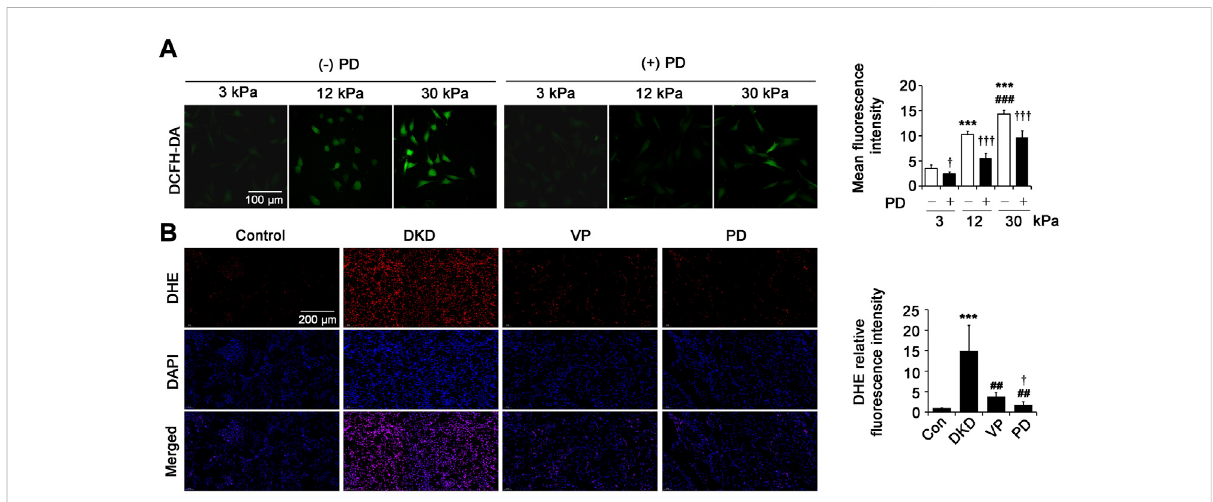
FIGURE 7 PD limits the increase of intracellular ROS in vitro and in vivo . (A) Immuno fl uorescence staining shows ROS level (DCFH-DA) in the renal fi broblasts cultured on PA gels with different stiffness (3 kPa, 12 kPa and 30 kPa) for 24 h * p < 0.05, ** p < 0.01, *** p < 0.001 vs 3 kPa; # p < 0.05, ## p < 0.01, ### p < 0.001 vs 12 kPa; † p < 0.05, †† p < 0.01, ††† p < 0.001 vs. (-) PD (n = 6). (B) The ROS level of kidney tissues was captured by CLSM at 8 weeks after successful DKD modeling (DHE fl uorescent staining). * p < 0.05, ** p < 0.01, *** p < 0.001 vs control (Con); # p < 0.05, ## p < 0.01, ### p